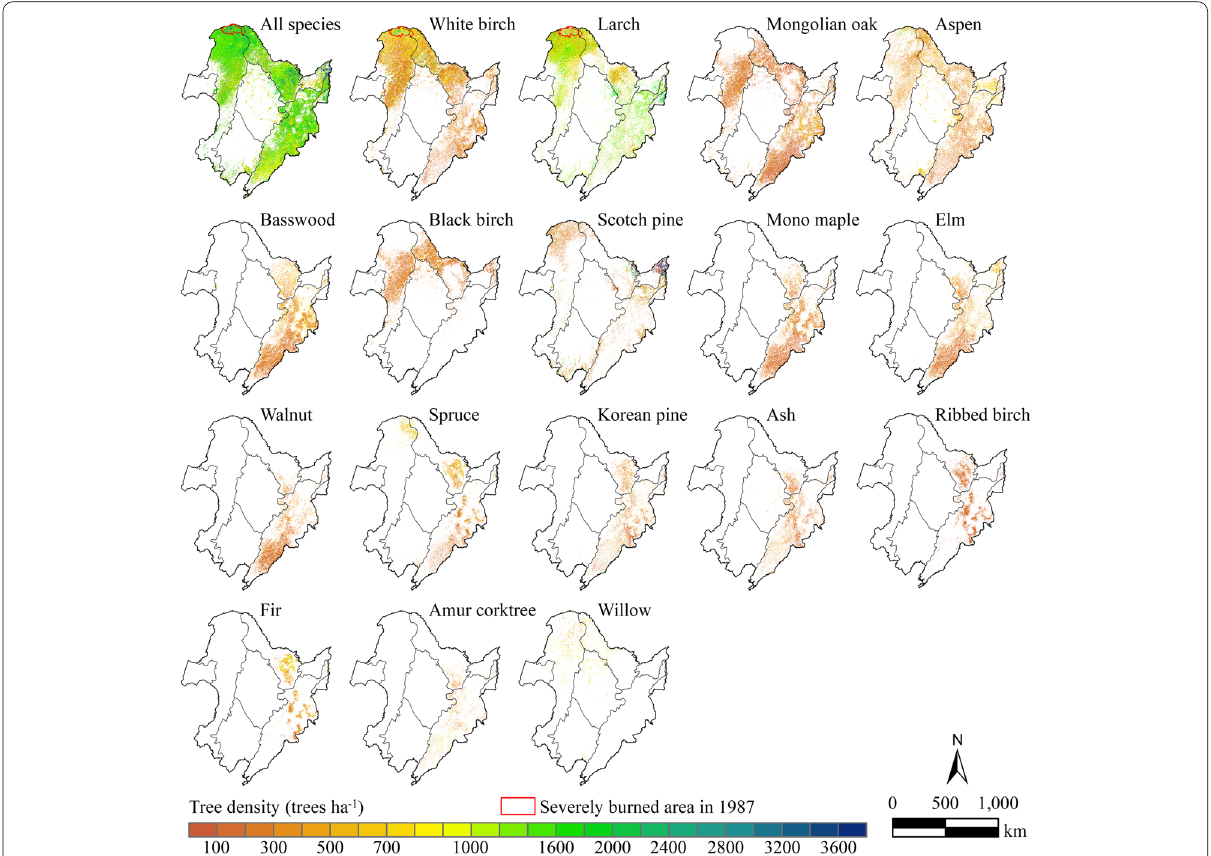
Fig. 8 Maps of total and species-level tree density in the forest region of Northeast China in